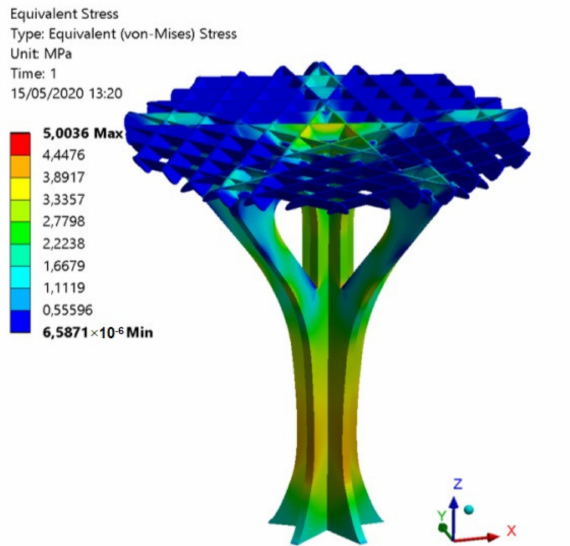
Figure 14. Field of displacements: ( A ) Z-axis printing direction; ( B ) X-axis printing direction; and ( C ) Y-axis printing direction.